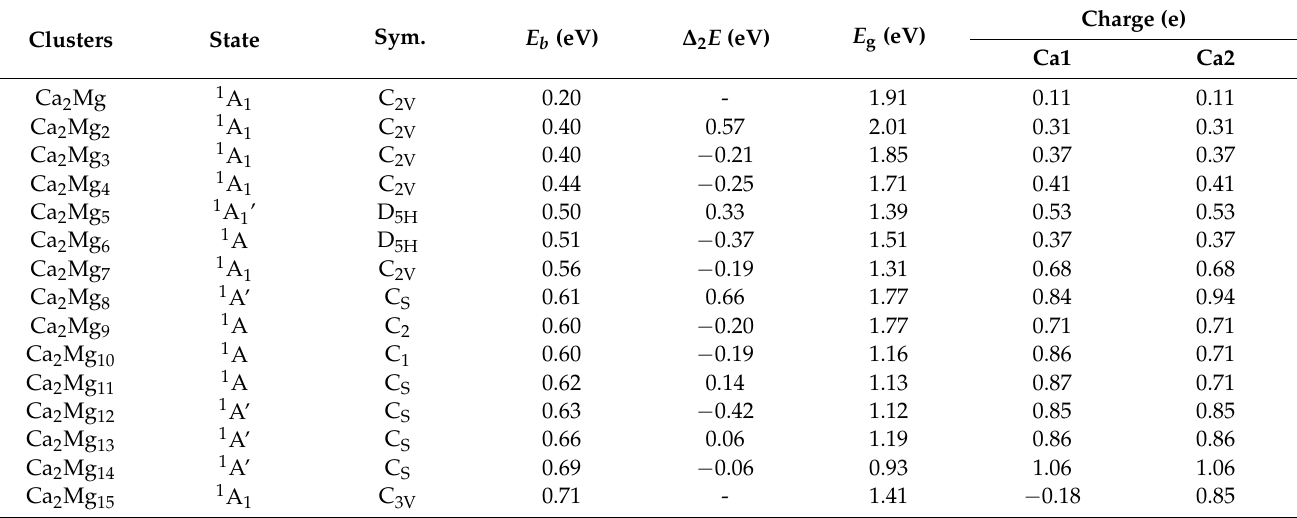
Table 1. Electronic states, symmetries, average binding energies E b (eV), HOMO–LUMO energy gaps E g (eV), the second-order difference energy ( ∆ 2 E ) and charges on the Ca atoms of the most stable Ca 2 Mg n ( n = 1–15)